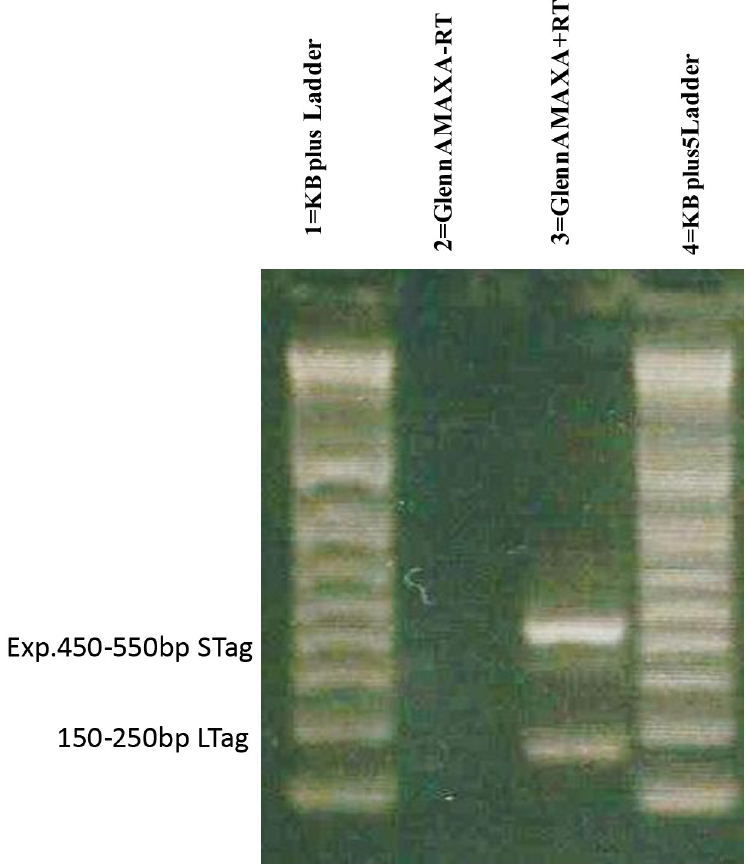
Fig 6. Detection of PCR products from other elephant primary endothelial cultures. Amplification of both AelPyV-1 LTag and STag DNA sequences from endothelial cells derived from an African elephant (Fitz, born 2019, Louisville, KY